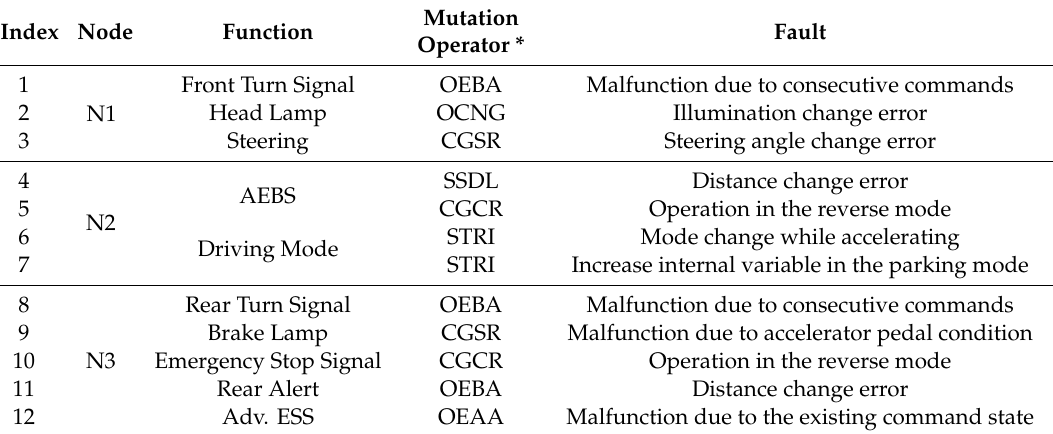
Table 1. List of fault injection by the selected mutation operators.